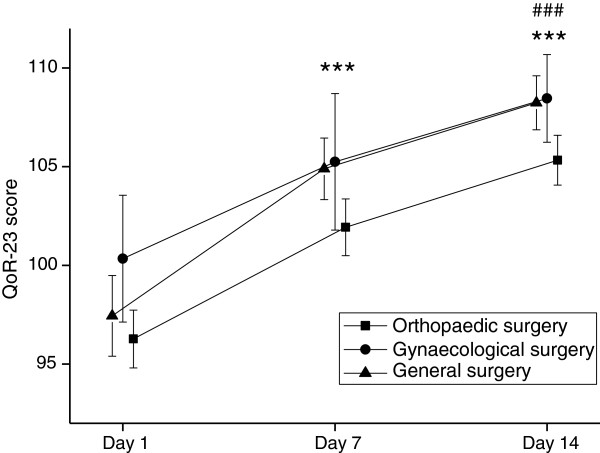
Improvements in recovery between postoperative days 1 to 7,7 to 14 and 1 to 14 in patients undergoing orthopaedic,general and gynaecological day surgery when assessed using the Quality of recovery-23 (QoR-23) scale. Means and 95% confidence intervals. *** denotes p<0.001 compared to day 1 and ### denotes p<0.001 compared to day 7 for all three groups separately.